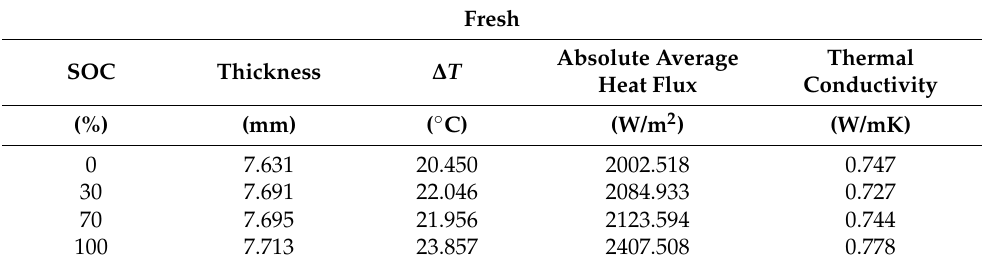
Table A1. Data used to calculate the thermal conductivity of fresh cells.